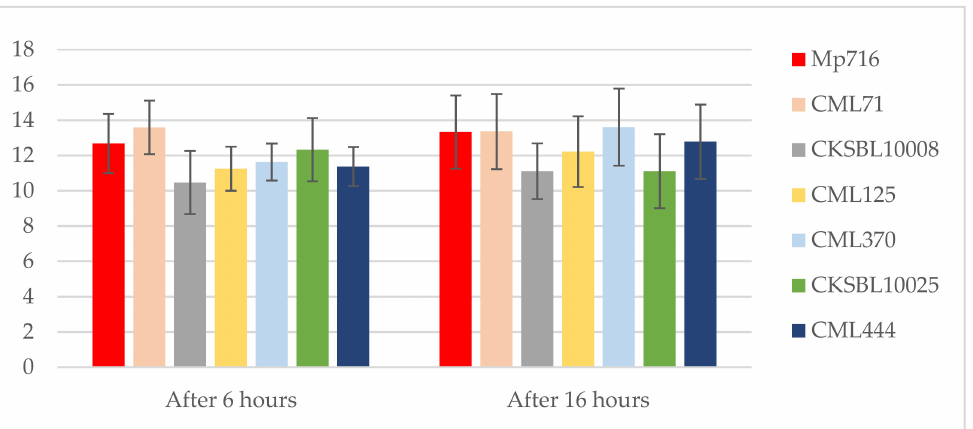
Figure 7. Mean percentage ( ± SE) of Spodoptera frugiperda neonates found on grain of each inbred line under multiple choice conditions after 6 (n = 41) and 16 (n = 36) hours of bioassay in a Petri